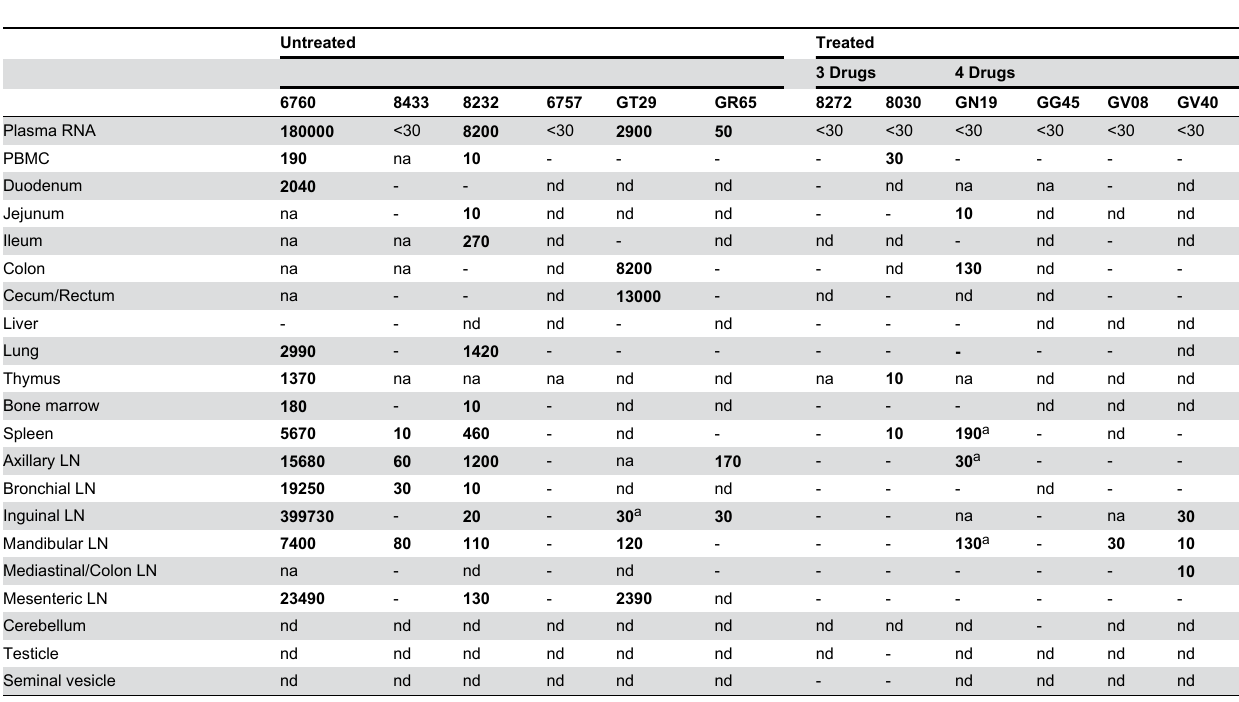
Table 2. gag RNA copies per 1x10 6 CD4 RNA copies per tissue at necropsy (week